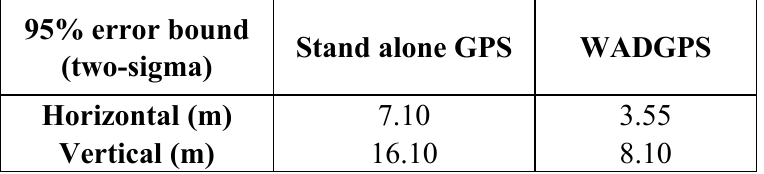
Table 3. Accuracy of the positioning performance (NSTB).